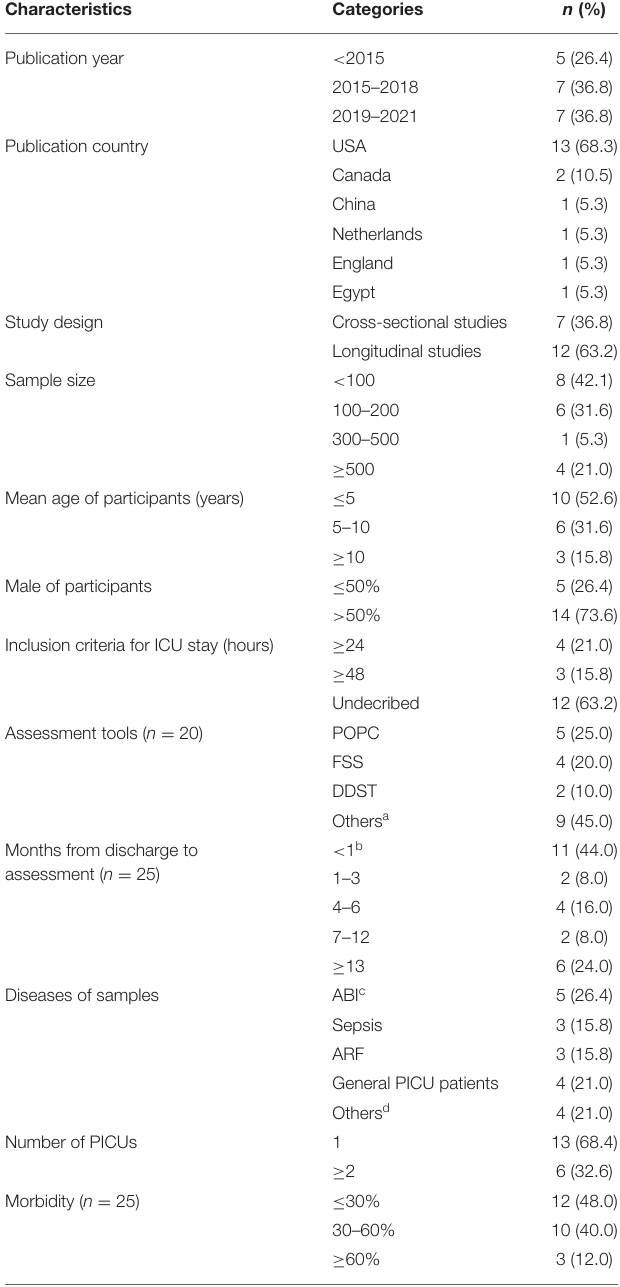
TABLE 1 | Study characteristics ( N =